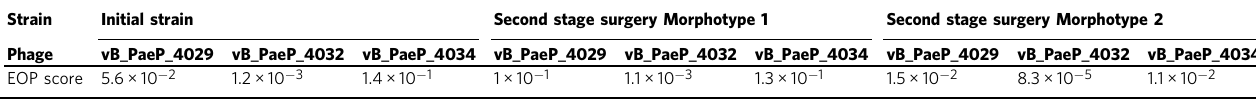
Table 2 Determination of EOP scores of the three phages on the patient ’ s strains isolated before phage therapy or during the second-stage surgery procedure (2 morphotypes, including one SCV morphotype).